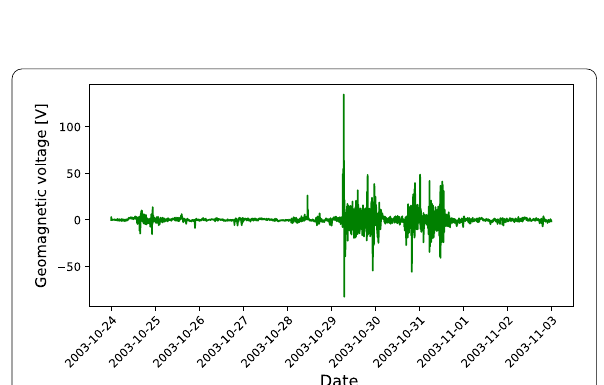
Fig. 4 Induced geomagnetic voltage for line V420 during Halloween